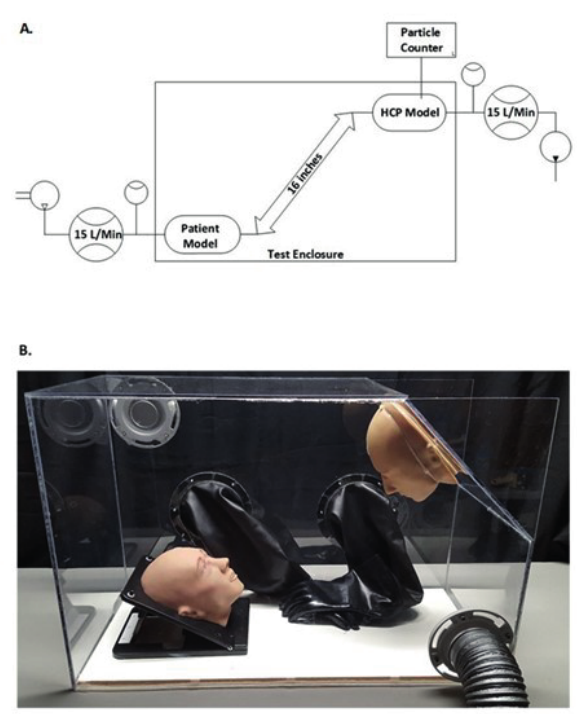
Figure 1. (A) Schematic diagram for the test fixture. (B) Test enclosure with patient and HCP